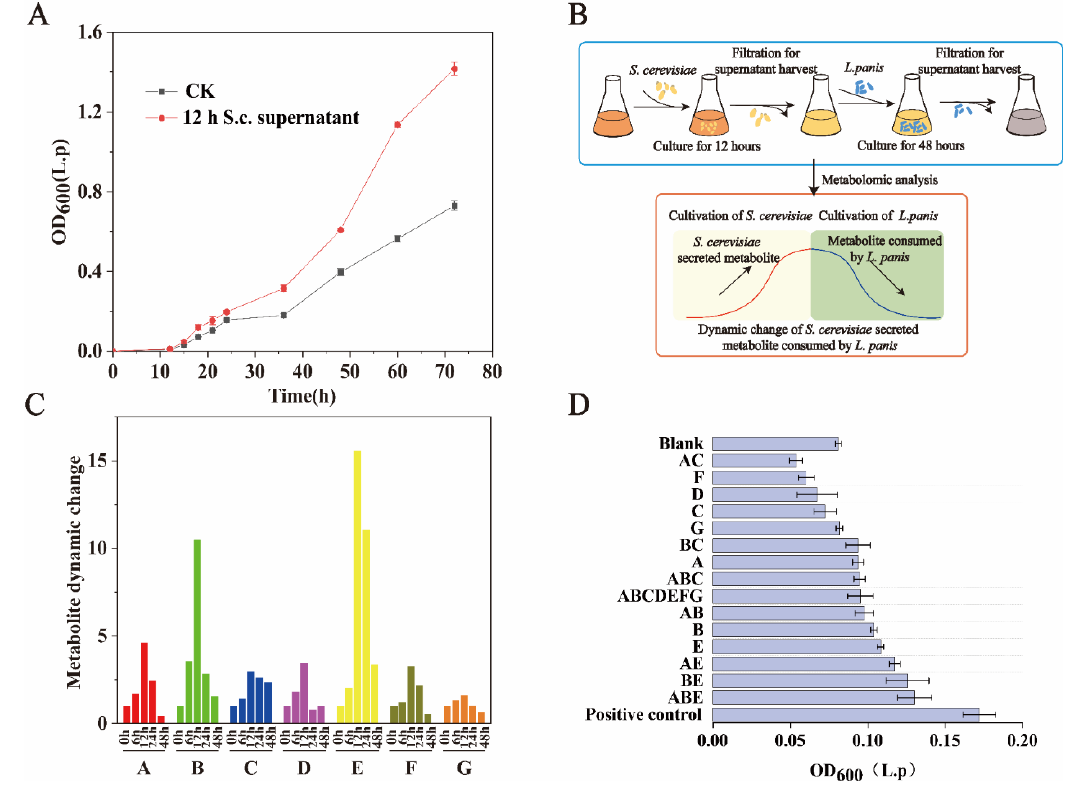
Figure 2. Identification of the key metabolites secreted by exponentially growing S. cerevisiae that promote L. panis growth. ( A ) Effects of fermentation supernatant of S. cerevisiae (12 h) on cell growth of L. panis . CK: Fermentation supernatant from cultivating S. cerevisiae at 0 h. ( B ) Sample preparation for metabolomics analysis to identify potential key metabolites secreted by exponentially growing S. cerevisiae . ( C ) Dynamic changes of seven potential key metabolites (compared to 0 h). 6 h, 12 h: fermentation supernatant of S. cerevisiae incubated for 6 and 12 h, respectively; 24 h, 48 h: fermentation supernatant from cultivating L. panis for 24 and 48 h, respectively. A: L-lysine, B: 5-S-methyl-5-thioadenosine, C: D-biotin, D: Pyruvic acid, E: L-methionine, F: Inosine, G: 2-deoxycytidine 5-monophosphate. ( D ) Effects of adding identified metabolites to sorghum fermentation medium on the growth of L. panis . A: L-lysine, B: 5-S-Methyl-5-thioadenosine, C: D-biotin, D: Pyruvic acid, E: L-methionine, F: Inosine, G: 2-deoxycytidine 5-monophosphate.